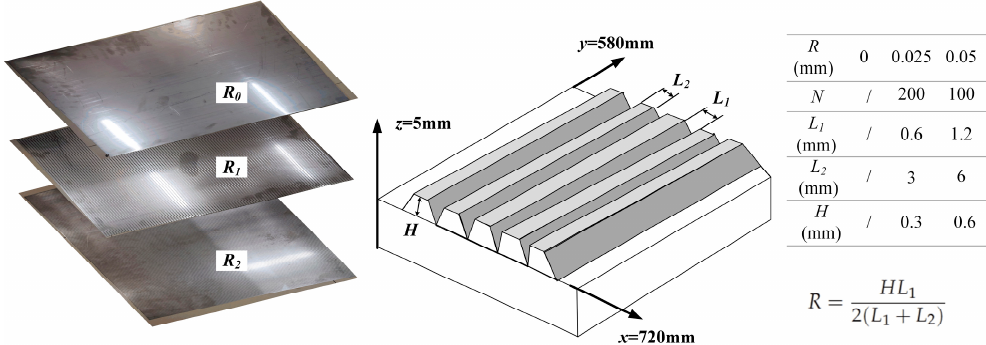
Figure 6. Steel plates with different roughness levels.